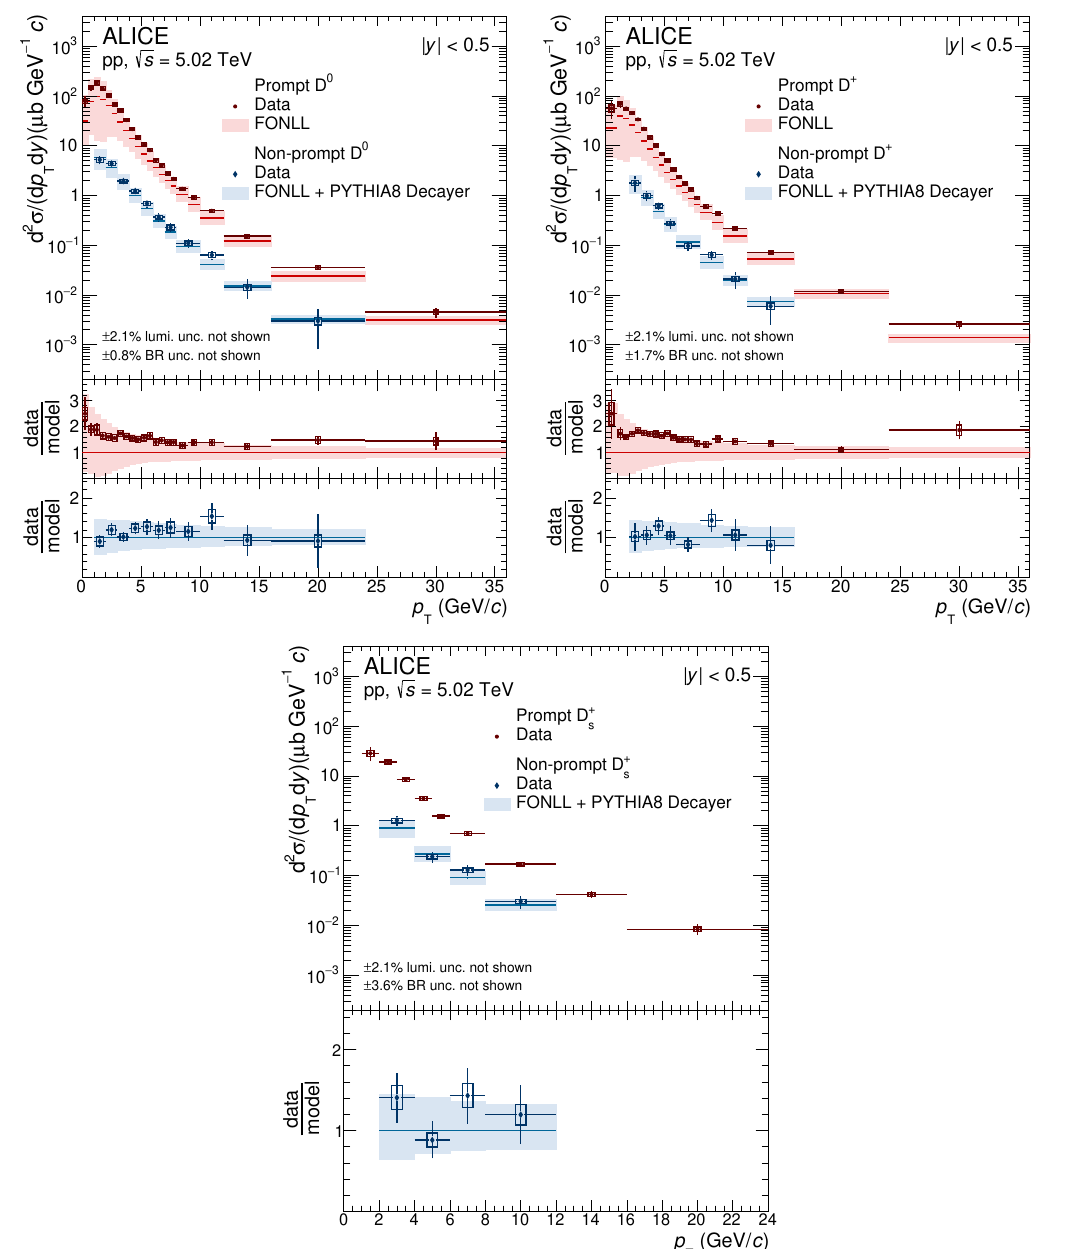
Figure 7 . p T -differential production cross sections of prompt and non-prompt D 0 (top left panel), D + (top right panel), and D + (bottom panel) mesons compared to predictions obtained with FONLL s calculations [56, 57] combined with PYTHIA 8 [70, 71] for the H b → D + X decay kinematics. The measurement of prompt D 0 mesons is the one reported in ref. [3], with updated decay BR as discussed in the